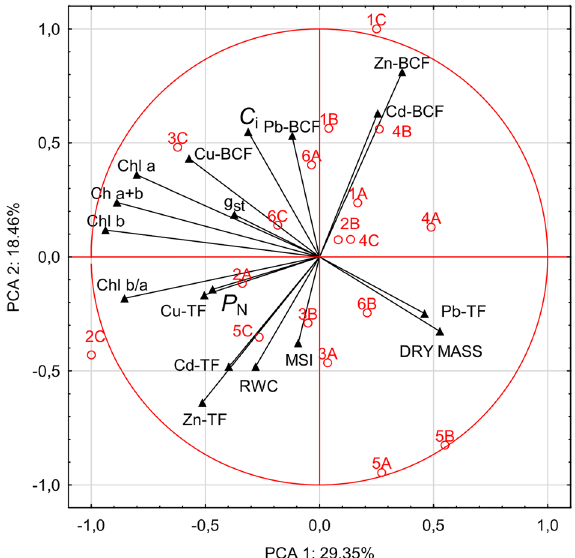
Figure 2. Principal component analysis of heavy metal concentrations, bioconcentration factor (BCF) and translocation factor (TF) in examined samples (abbreviations see “Materials and methods”) in relation to photosynthesis activity parameters: net photosynthetic rate P N , stomatal conductance g s and intercellular CO 2 concentration and ( C i), chlorophyll parameters and dry mass, relative water content (RWC) and cell membrane stability